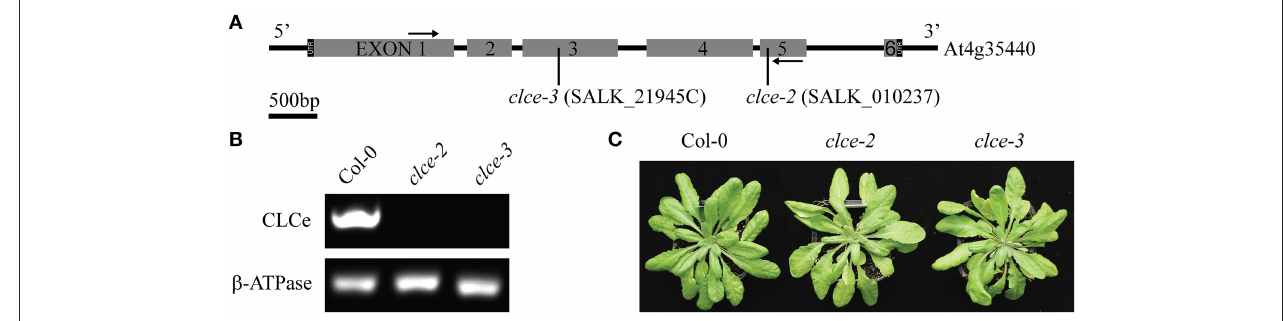
FIGURE 1 | Genotyping of clce mutants used in this study. (A) AtCLCe gene structure with indicated location of T-DNA insert in each of the two clce lines. Black arrows indicate location of primers used for RT-PCR. (B) RT-PCR of total RNA from wild-type (Col-0) and clce leaves with primers specific for the AtCLCe gene and primers for a reference gene as the positive control. (C) Representative photos of 7-week-old plants.